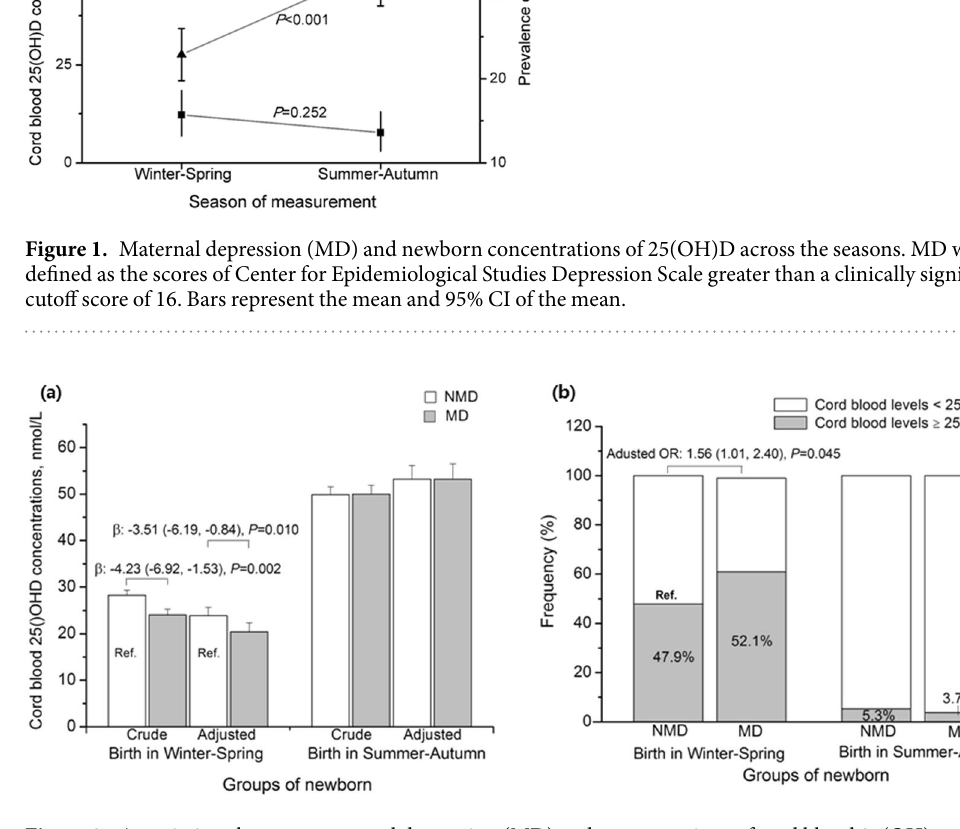
Figure 2. Associations between maternal depression (MD) and concentrations of cord blood 25(OH) D stratified by season. The differences of concentrations of cord blood 25(OH)D and the risks of 25(OH) D < 25 nmol/L in the newborn of MD versus the newborn of non-MD were assessed using linear regression models and logistic regression models, respectively. Multiple regression models were adjusted for maternal sociodemographic characteristics, perinatal health status, lifestyle and birth outcomes. MD was defined as the scores of Center for Epidemiological Studies Depression Scale greater than a clinically significant cutoff score of 16. Bars represent the mean ± SE. OR, odd ratios; β ,